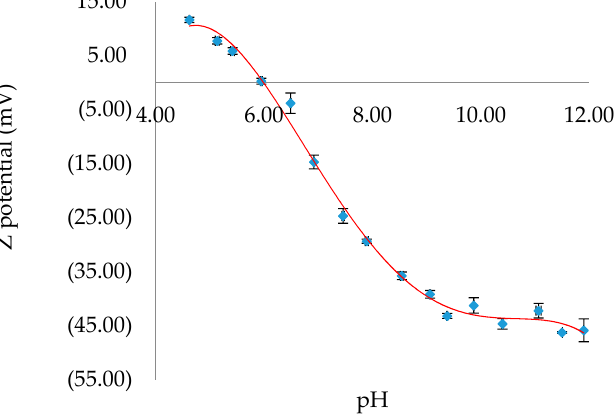
Figure 8. Variation of the Z potential of CuO NPs with pH. The values of Z potential were given as mean ± SD of triplicate samples. The best fit trend line in red.